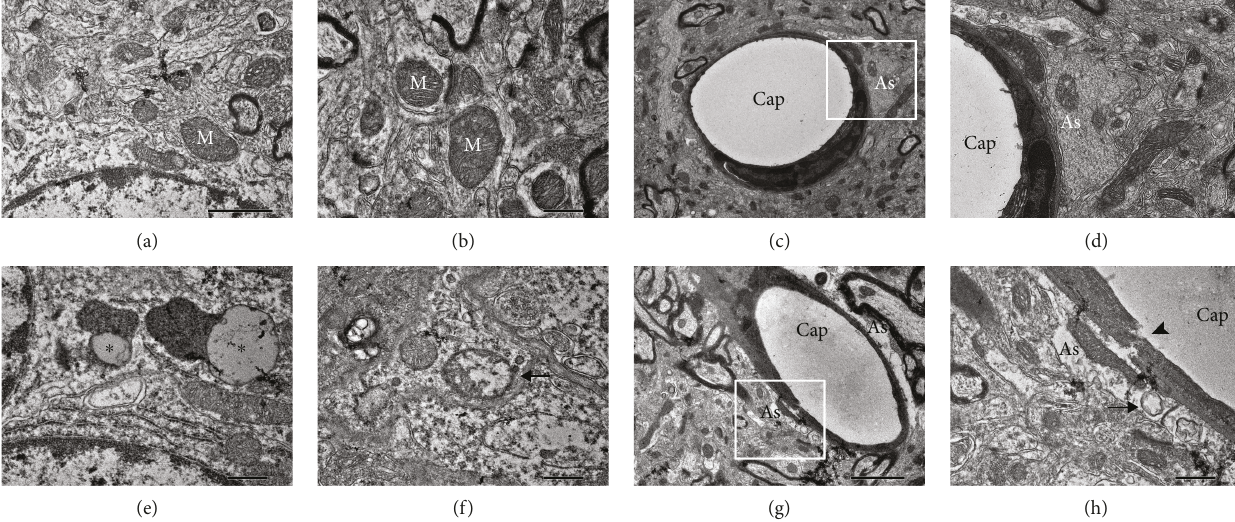
Figure 5: Ultrastructure in the auditory cortex of rats in the ZDF and control groups. (a, b) Normal mitochondria (white M) in the control group. (c, d) Normal pro fi le of the neurovascular unit composed of astrocyte processes (white As) in the control group. (e) Lipofuscin granules ( ∗ ) in the ZDF group. (f) Enlarged mitochondria with reduced electron density in the matrix (arrow) in the ZDF group. (g, h) Neurovascular breakdown in the ZDF group: the disruption of capillary epithelia (arrowhead), enlarged astrocyte endfeet (black As), and severe degeneration of mitochondria (arrow). Scale bars: a = b = c = e = f = h = 0 5 μ m and c = g = 2 μ m . As: astrocyte processes; Cap: